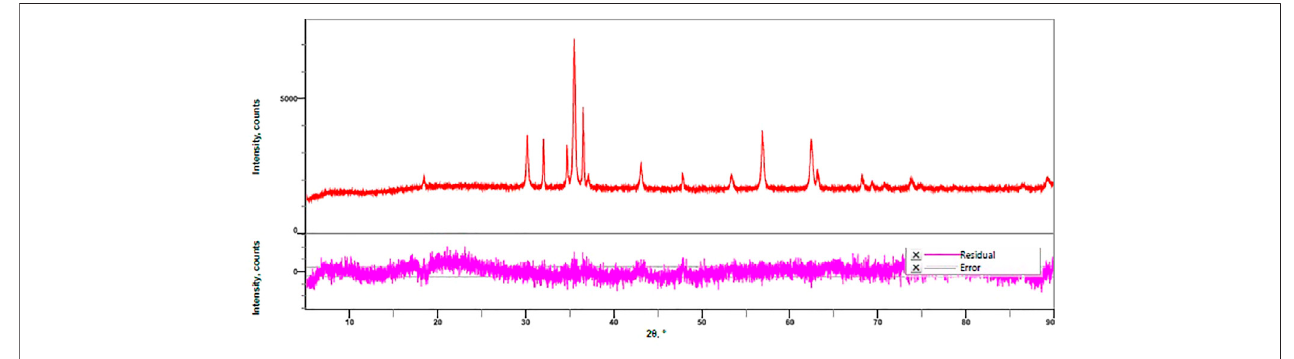
FIGURE 2 | XRD analysis of zinc doped iron nanocatalyst.